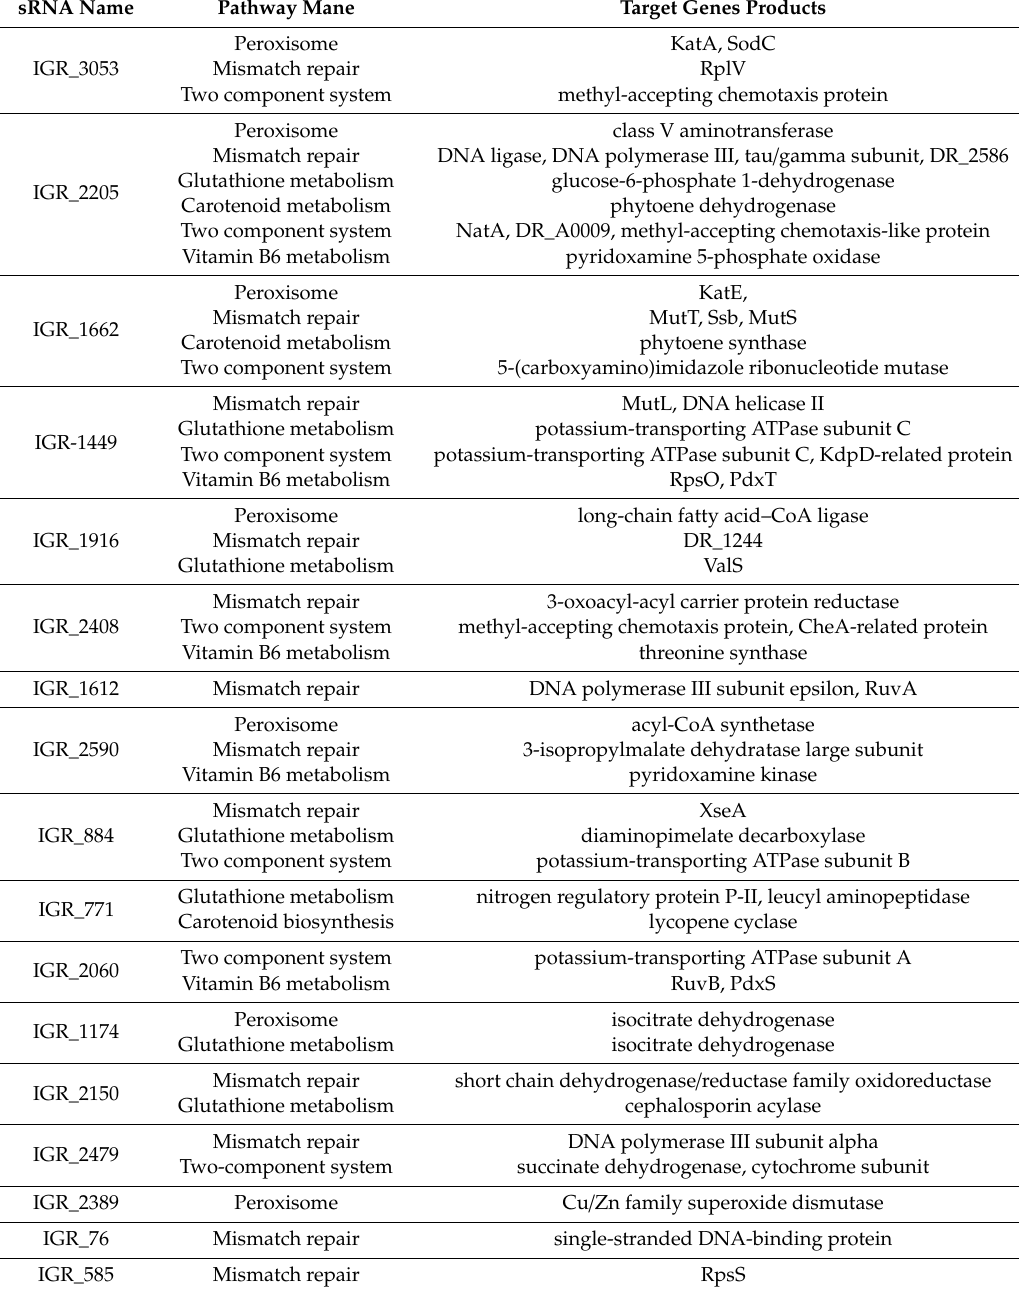
Table 2. Functional annotation of oxidative response sRNAs in the KEGG